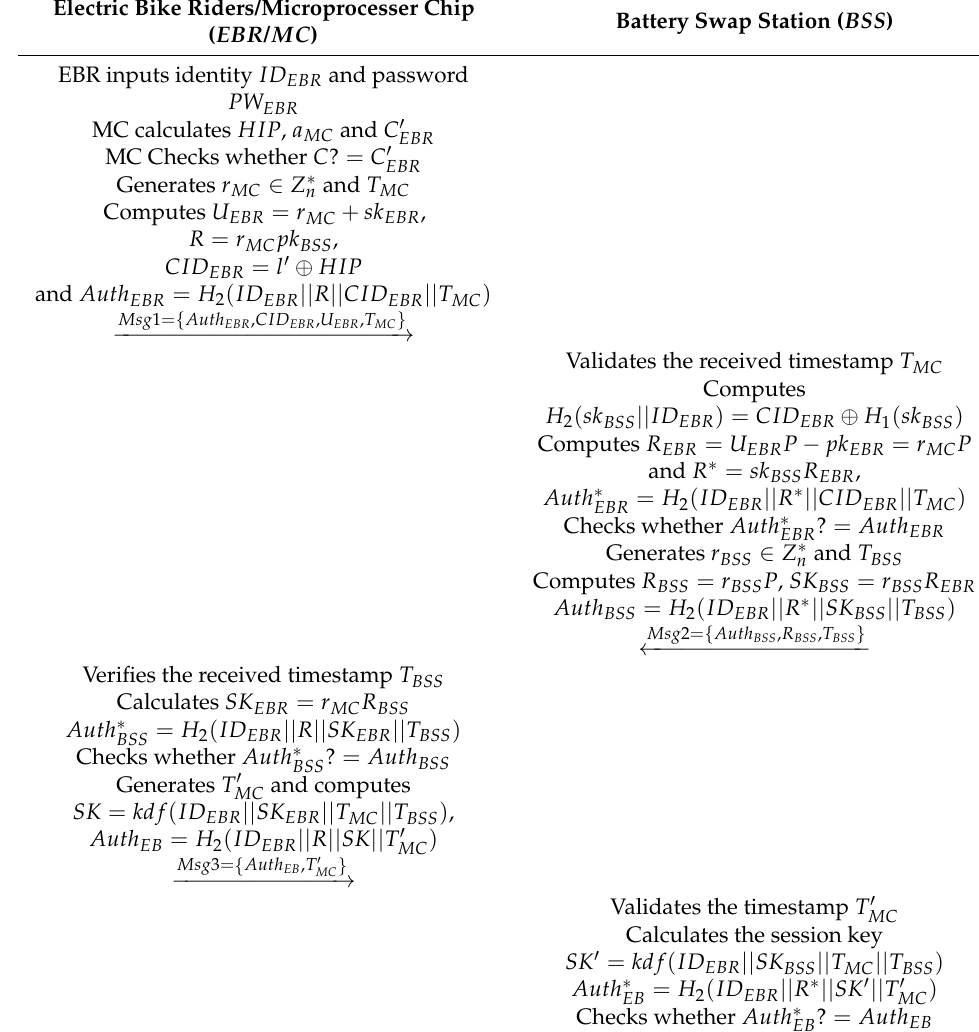
Table 4. Mutual authentication and key exchange